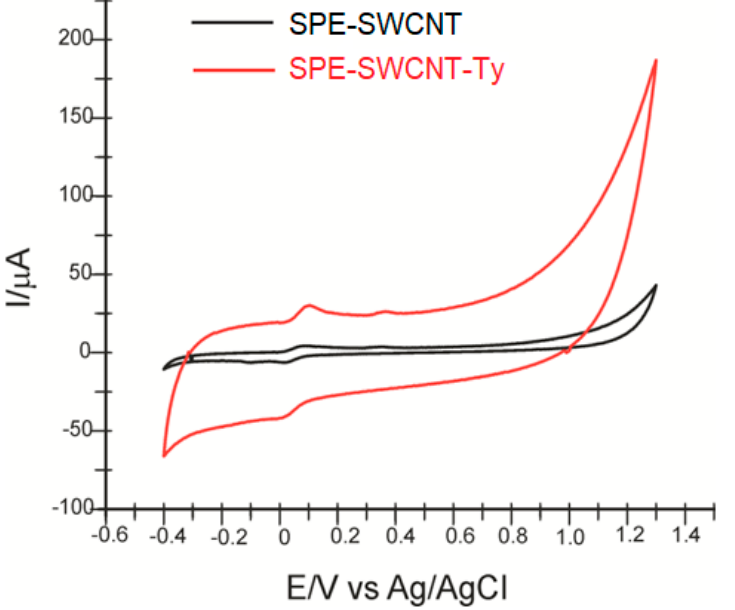
Figure 5. Cyclic voltammograms of SPE-SWCNT (black line) and SPE-SWCNT-Ty (red line) in PBS solution 10 − 1 M (pH 7.0) containing 10 − 4 M HT. Scan rate: 0.1 V · s − 1 .